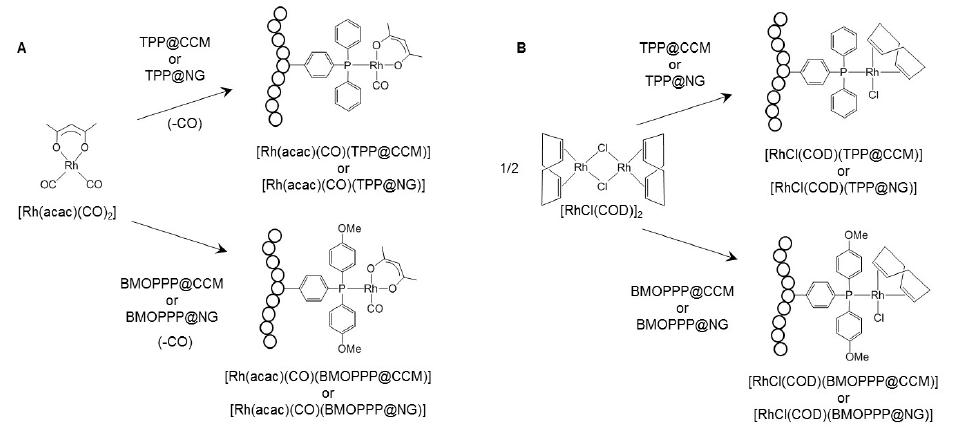
Figure 2. Coordination of the pre-catalyst to the polymeric nanoreactors.